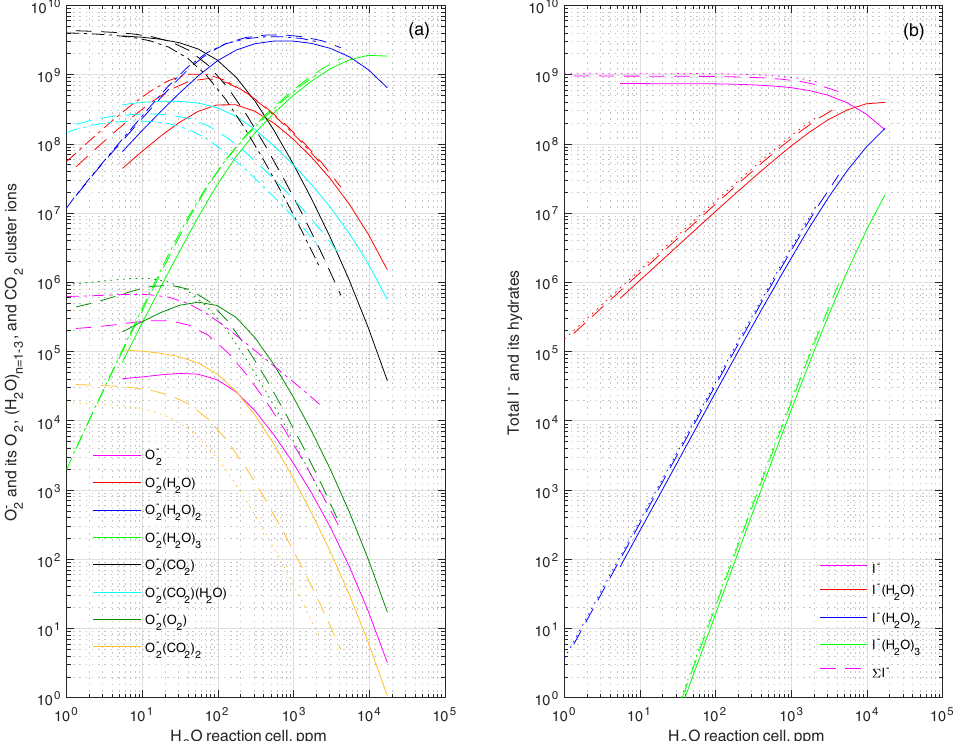
( H 2 O ) n = 1 , 3 , O − ( CO 2 ) n = 1 , 2 , O − ( CO 2 )( H 2 O ) and O − ( O 2 ) , as a function of water vapor , O − 2 2 2 2 2